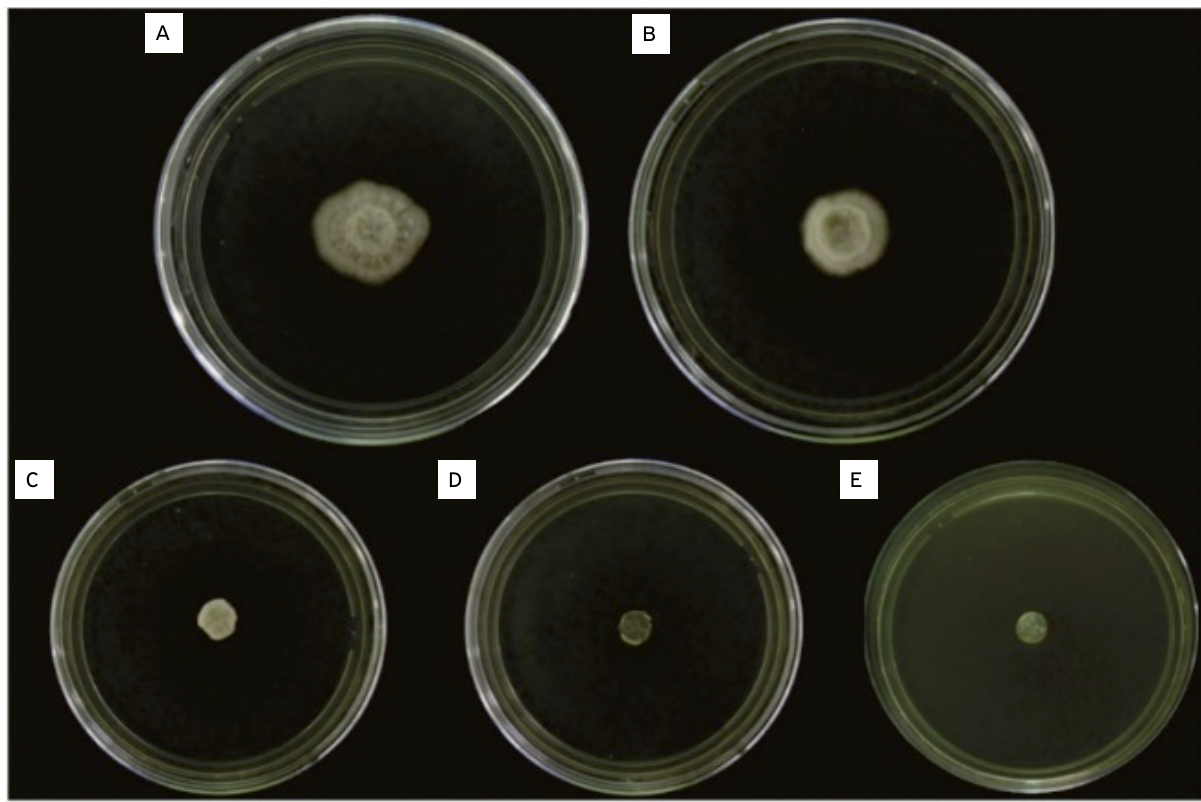
Figure 2. Illustration of mycelial area. Treatments: (A) Control 01 PDA, (B) Control 02 (PDA+TSB), (C) metabolites 10%, (D) metabolites 20%, (E)